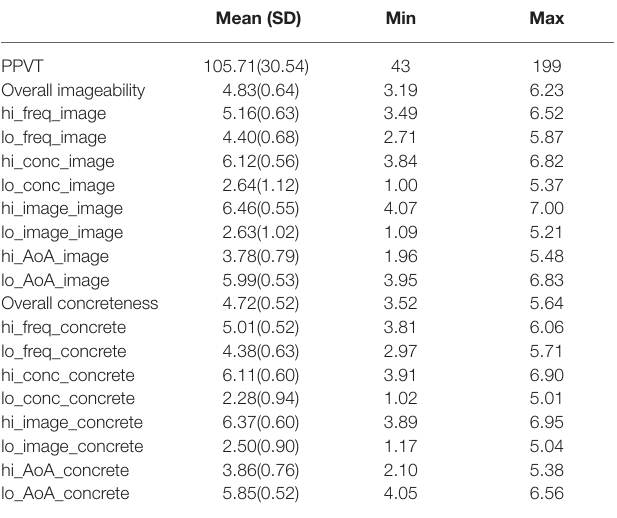
TABLE 2 | Descriptive values of PPVT-IV and all main and subscores of imageability and concreteness ratings. Mean (SD) Min Max